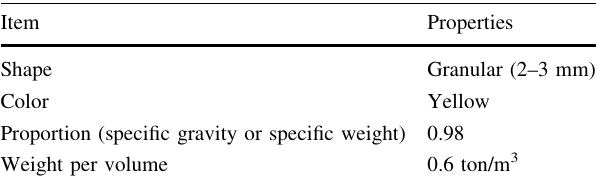
Table 2 Physical properties of TAFPACK-Super (TPS) asphalt modifier